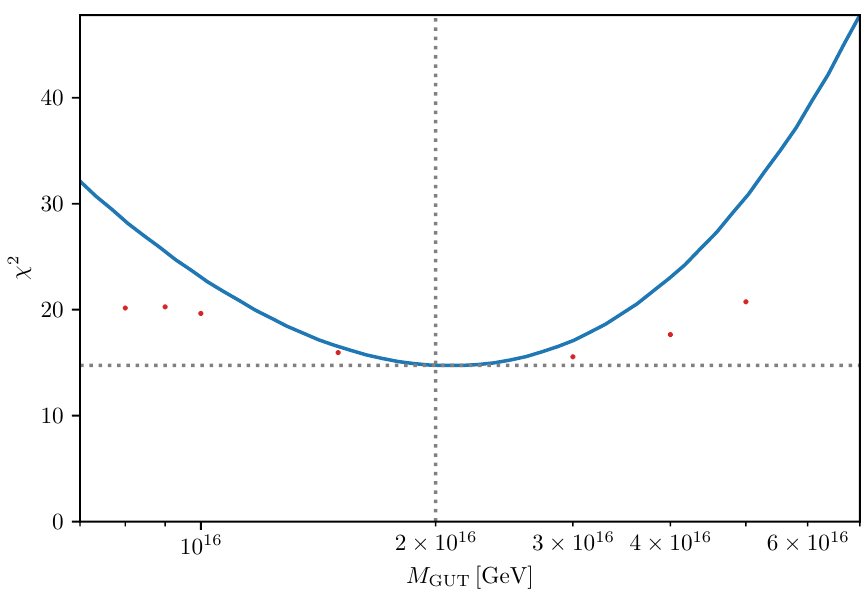
Figure 3 . Variation of the (cid:31) 2 function with M GUT . The blue curve shows the result of varying M GUT , while keeping the same best-(cid:12)t parameter values. The red dots show the result of performing local optimization around the best-(cid:12)t parameter values for some selected values of M GUT